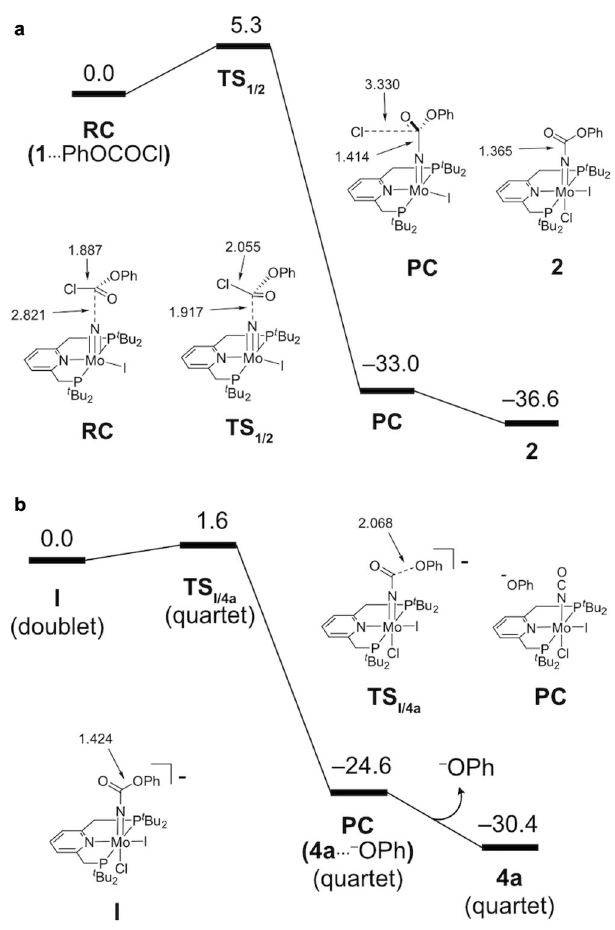
Fig. 5 | A possible reaction pathway for the conversion of nitride complex 1 to isocyanate complex 4a. a Free energy pro fi le at 298K ( Δ G 298 ) calculated for the reaction of nitride complex 1 with phenyl chloroformate yielding carbamate complex 2 in the closed-shell singlet state. Selected interatomic distances are presented in Å. b Free energy pro fi le at 298K ( Δ G 298 ) calculated for the formation of 4a from I in the ground spin state (see more details in Supplementary Infor- mation). Selected interatomic distances are presented in